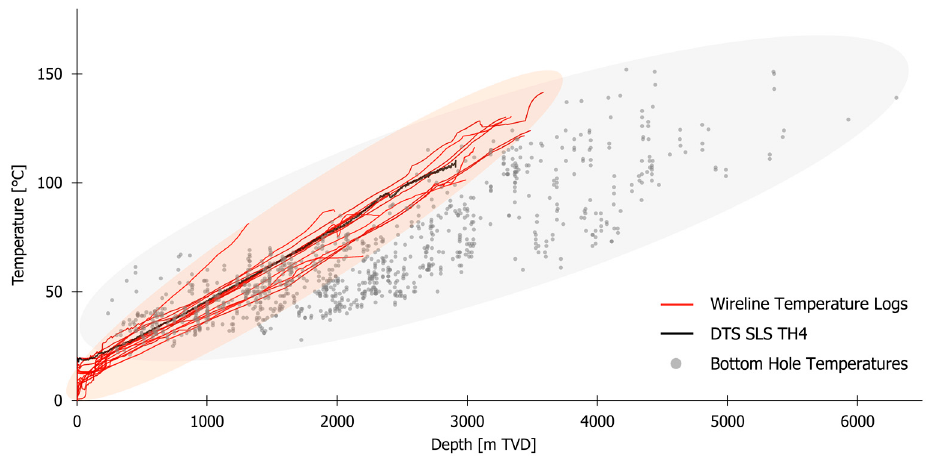
Figure 2. BHT values and temperature profiles available for the Bavarian Molasse Basin temperature data set versus depth. The black profile is from a fiber-optic DTS measurement in well SLS TH4 at the Schäftlarnstraße geothermal site. Table 1. The BHT data set structured in steps of 500 m TVD regarding the shut-in